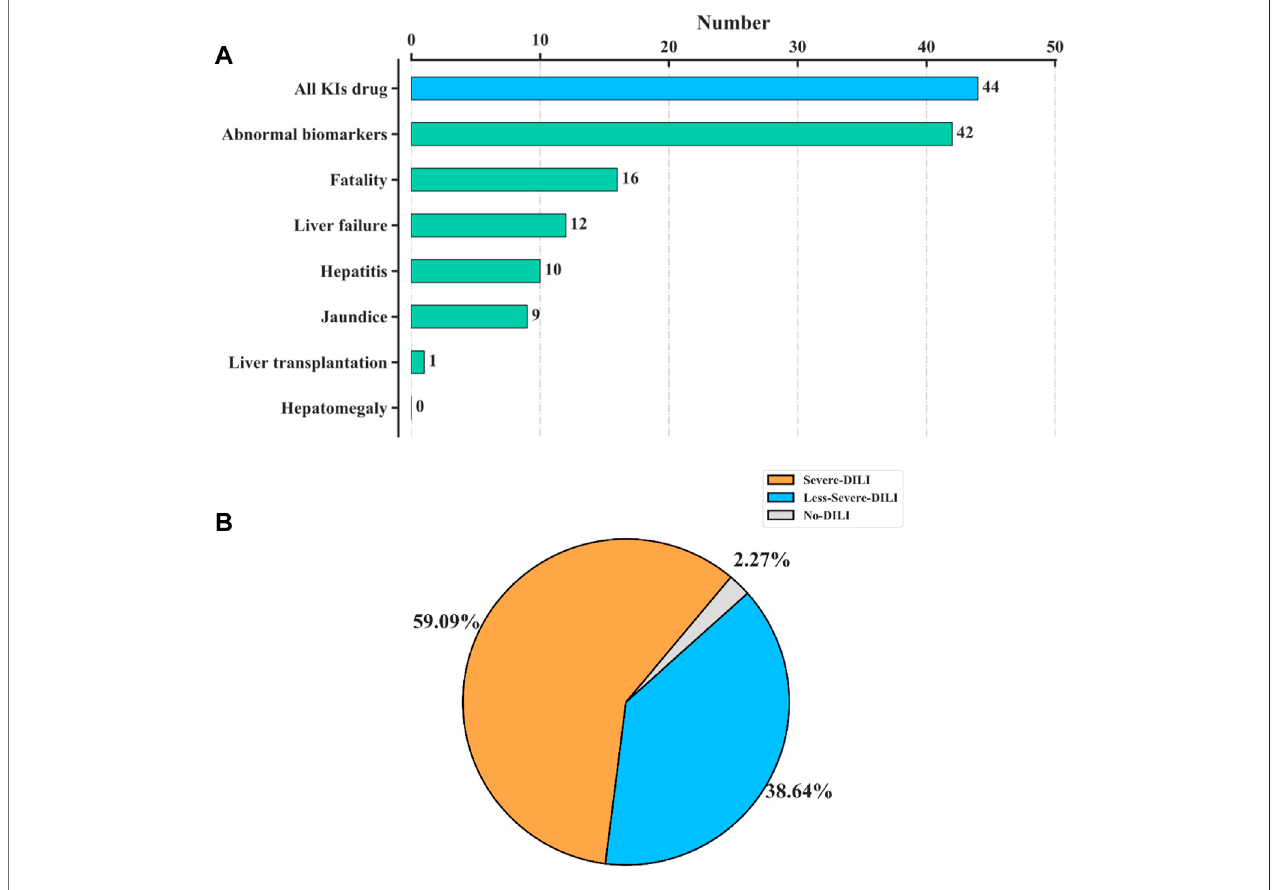
FIGURE 1 | Statistics of 44 kinase inhibitors (KIs) on DILI. (A) Numbers of different DILI endpoints reported in KIs. For the 44 KIs collected in our data, 16 of them maycausedeath,and12mayleadtoliverfailure. (B) Piechartofthe44KIsbythreeDILIseverenesscategories, “ severeDILI, ”“ less-severeDILI, ” and “ noDILI. ” Atotalof 43 of the 44 KIs (97.7%) were reported with DILI, while 26 (59.09%) may lead to severe DILI.